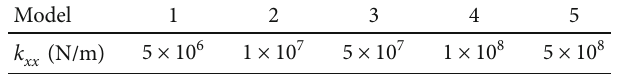
Table 8: Radial sti ff ness of shared support structure